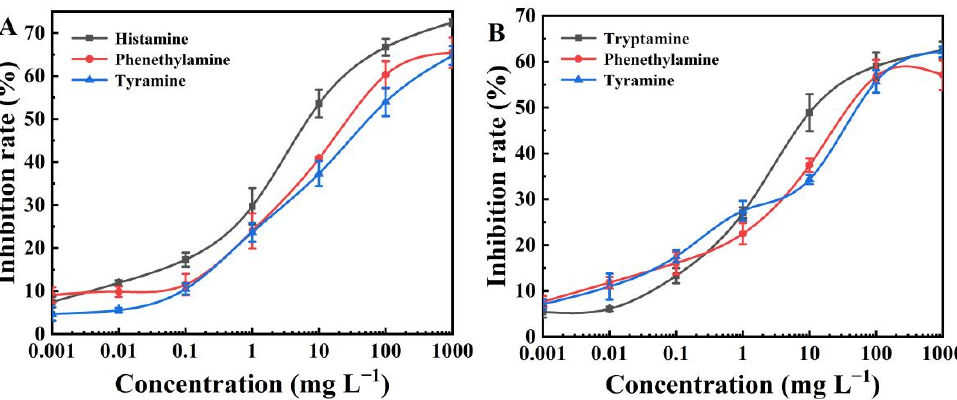
Figure 4. ( A ) BELISA standard curves for histamine, phenethylamine, and tyramine; ( B ) BELISA standard curves for tryptamine, phenethylamine, and tyramine.